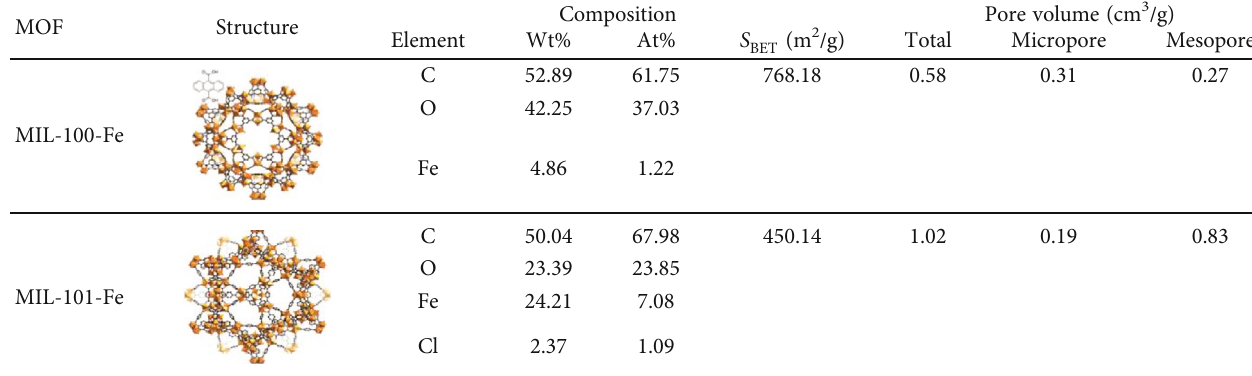
Table 2: Elemental analysis and textural parameters of MIL-100-Fe and MIL-101-Fe MOFs. MOF